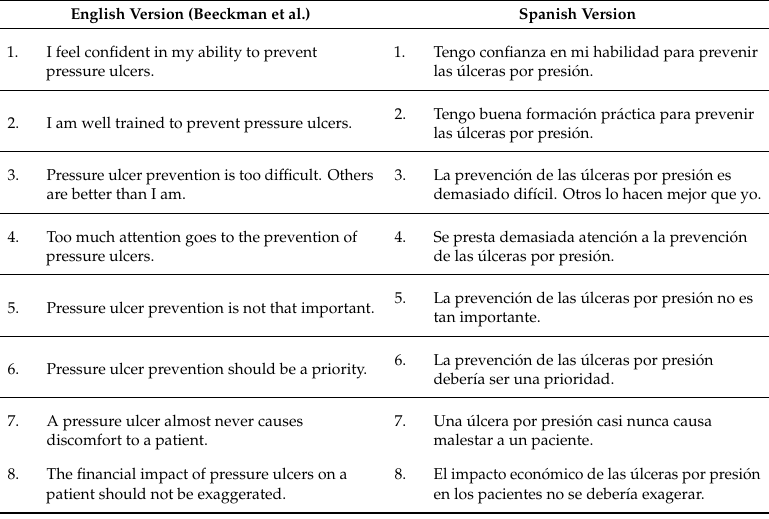
Table 1. TheAttitudetowardsPressureulcerPrevention(APuP)questionnaire,EnglishandSpanishversions. English Version (Beeckman et